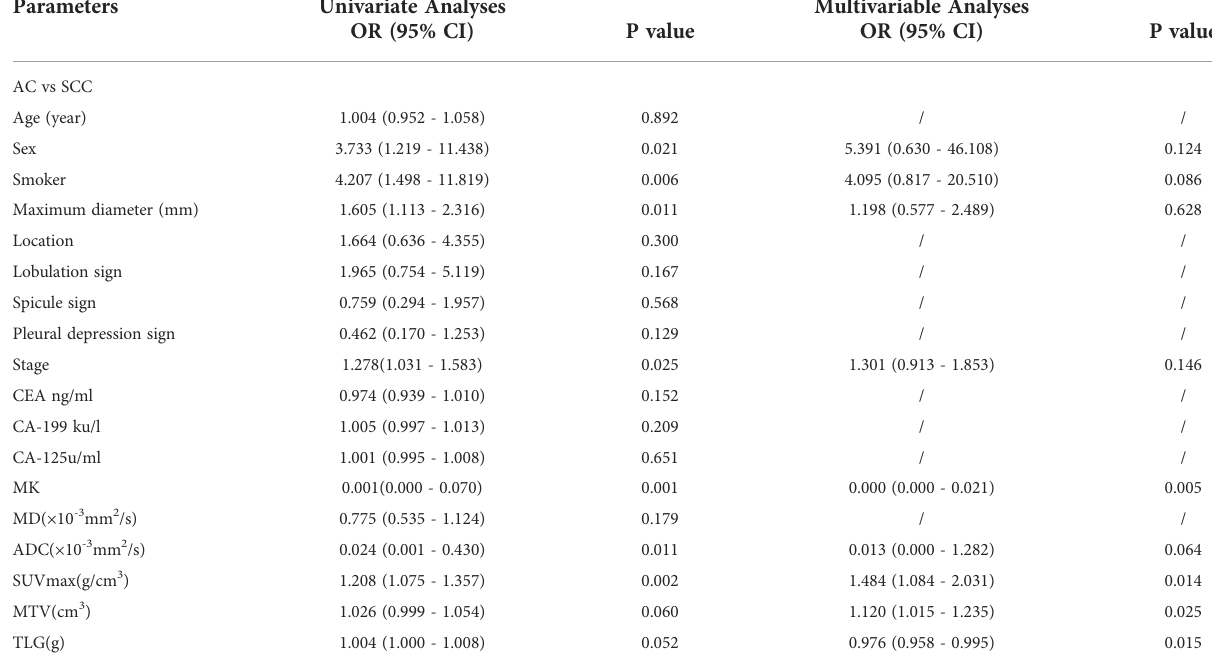
TABLE 4 Univariate and multivariate analyses were performed on factors associated with NSCLC. Parameters Univariate